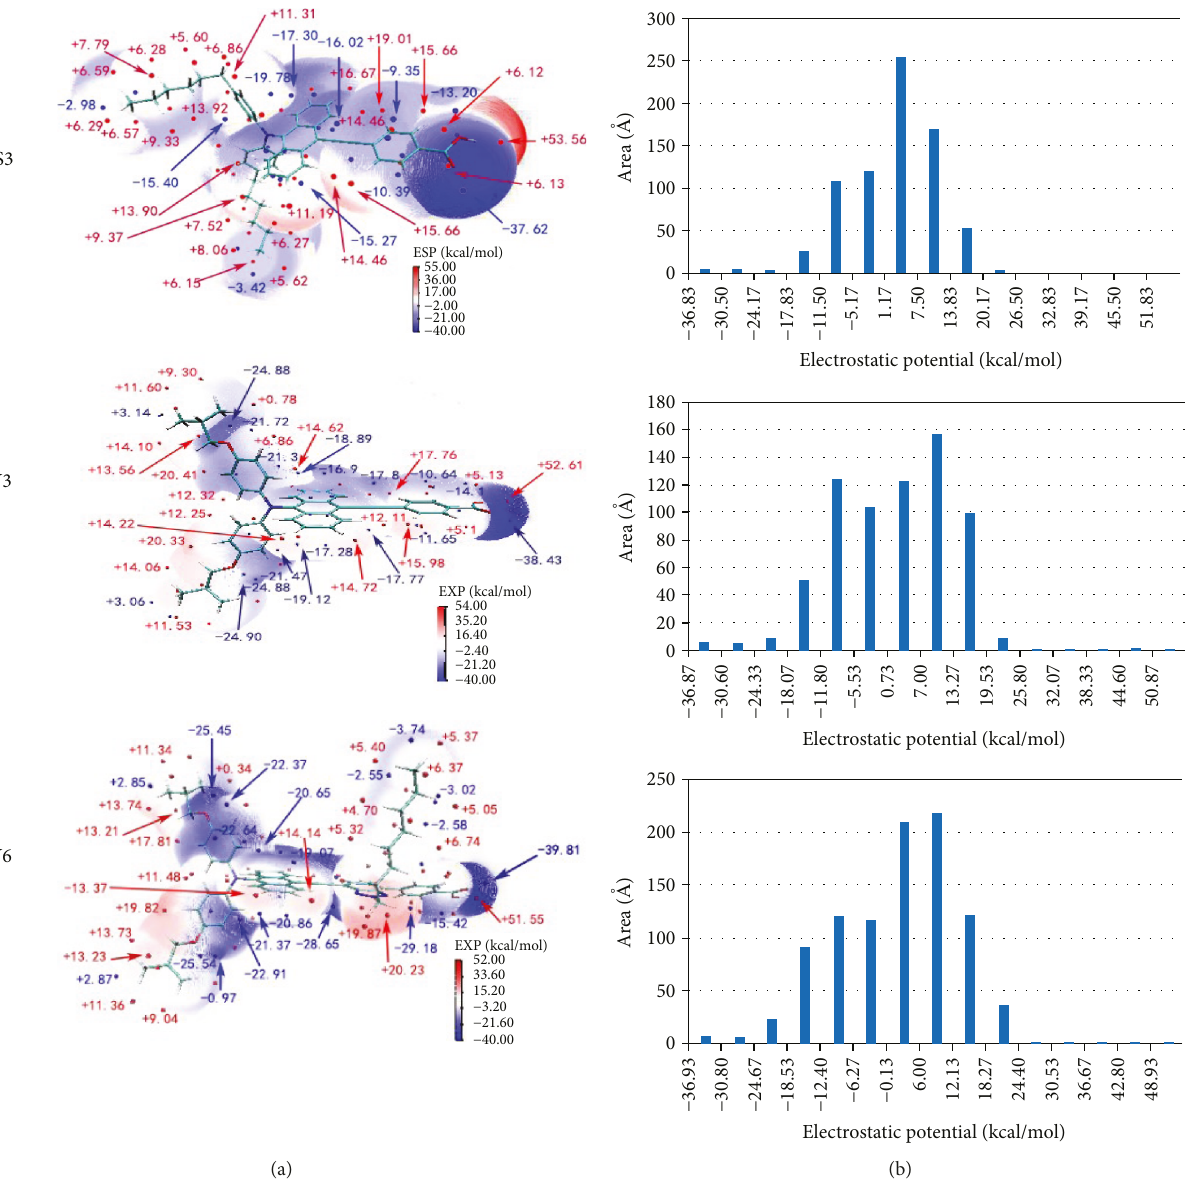
Figure 7: (a) The ESP on the VDW surface of MS3, TY3, and TY6; red and blue points represent maximum and minimum values, respectively. The extrema ESP (in kcal/mol) points on the molecular surface are marked. (b) The molecular surface area of di ff erent electrostatic potential interval; the electrostatic potential interval is divided into 15 equal